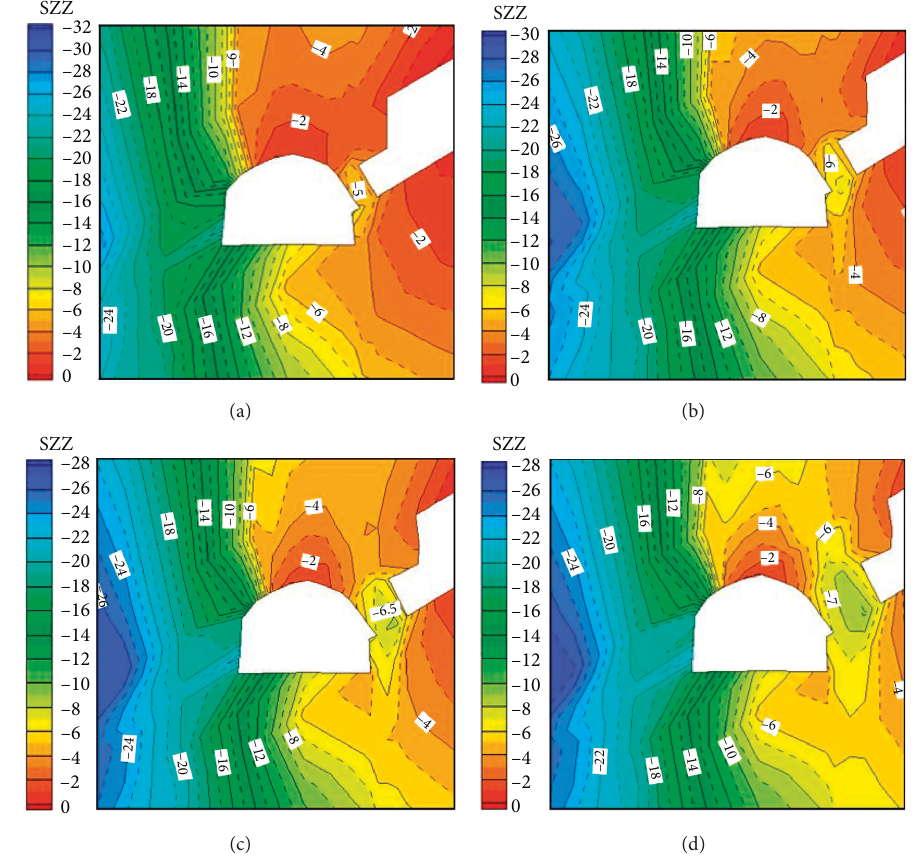
Figure 14: Vertical stress distributions of different GSSB widths: (a) 0.5m, (b) 0.75m, (c) 1.0m, and (d) 1.5